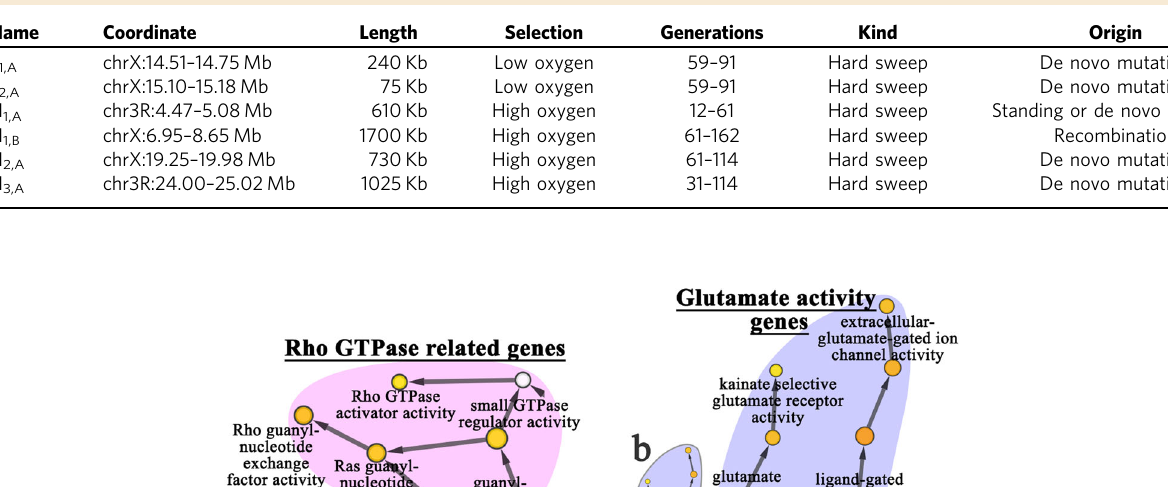
Table 2 Selected intervals where the selected intervals appear in one of the three biological replicates (individual sweeps).